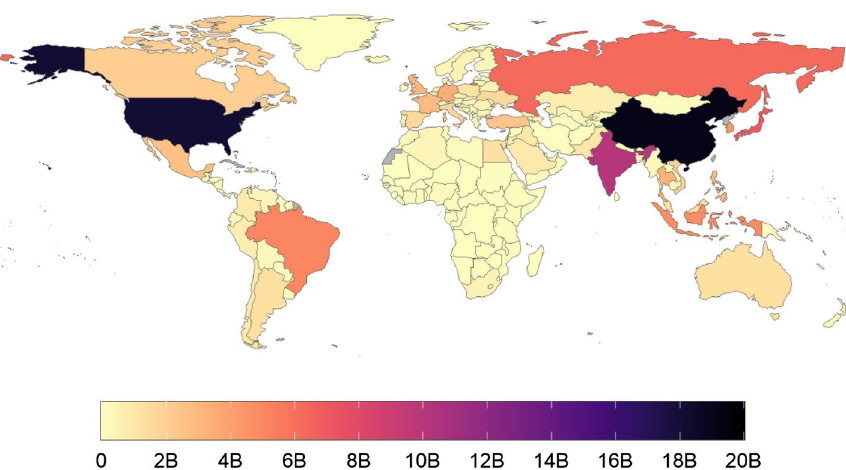
Figure 2. Heatmap of total mobile gaming hours, Oct 2020–2021. B = Billion. Countries/regions with no data in grey colour. This map was generated using ggplot in R (v4.0.2). Code for reproducing these maps is available at the OSF repository associated with the